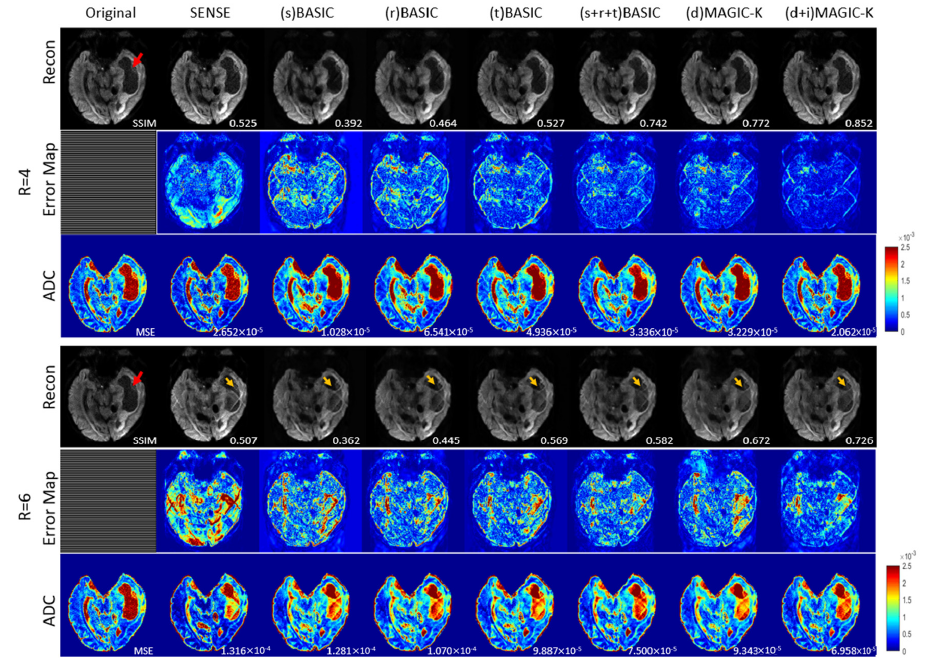
Figure 8. Comparison of the reconstructed images by different image augmentation strategies using uniform undersampling in a tumor patient with glioblastoma. The SSIM is listed at the bottom-right of each reconstructed image. The error map was ×10 amplified for better visualization. The MSE is listed at the bottom-right of each ADC map. Aliasing artifacts are depicted by the yellow arrows. The edema is depicted by a red arrow.